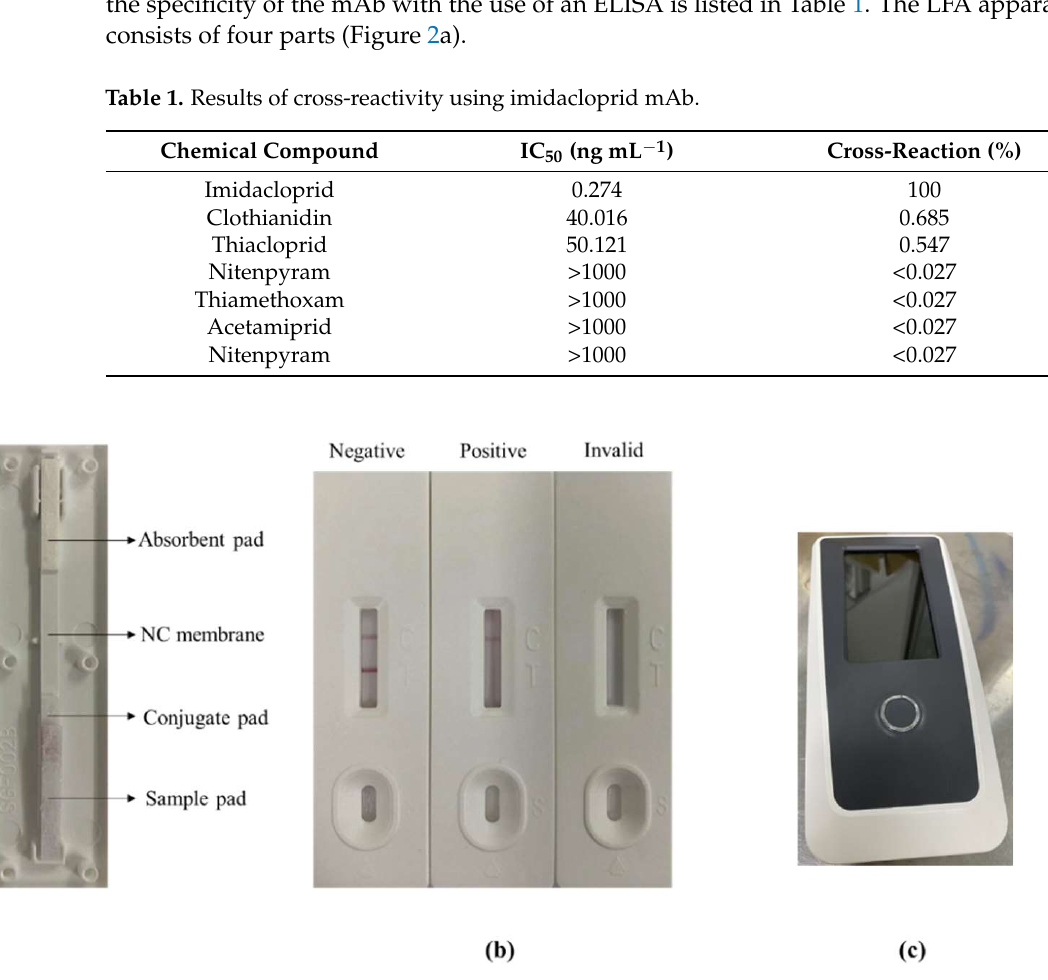
Figure 2. Parts of the LFA strip ( a ). Diagram of test results ( b ). Strip reader ( c ). The interaction between the analyte (sample) and the conjugate (labelled antibody) will migrate towards the NC membrane. Then, slowly, a red-colored band on the C and T lines will develop, depending on the concentration of IMP. A negative result (no IMP standard) is indicated by two red-colored bands at both of the lines. Only a red-colored band on the C lines indicates a positive result. The lack of a red-colored band at both lines indicates that the test procedure is invalid (Figure 2b). The strip reader was used to determine the color intensity that developed on both of the lines (Figure